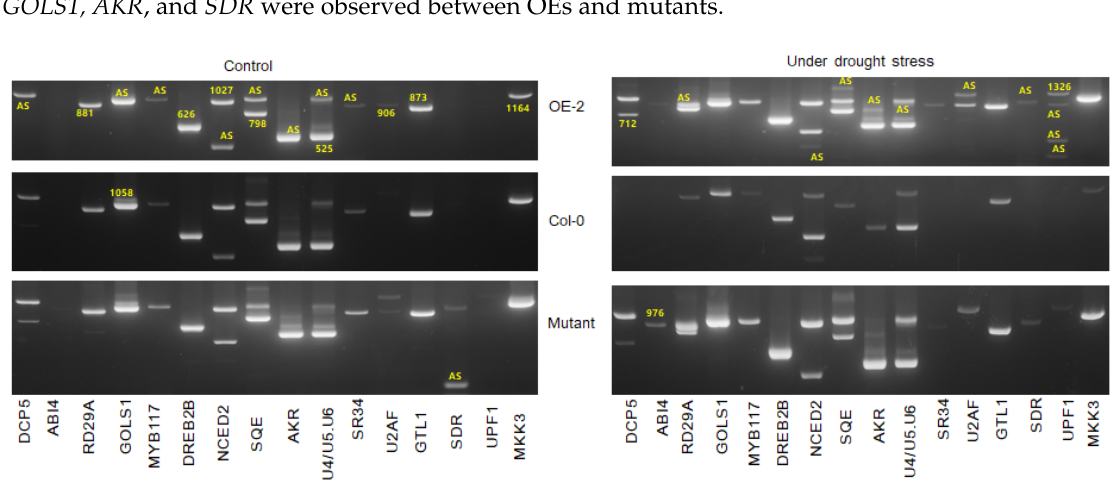
Figure 7. Differential alternative splicing of some of the SR45a ‐ interacting genes and known drought ‐ response genes in leaf samples collected from BrSR45a overexpressing, knock ‐ out mutants (SALK_052345) and wild (Col ‐ 0) type Arabidopsis lines under control and drought stress (15 d) conditions. AS represents the alternatively spliced transcripts while, the numbers represents the length (in nucleotides) of the original transcripts.